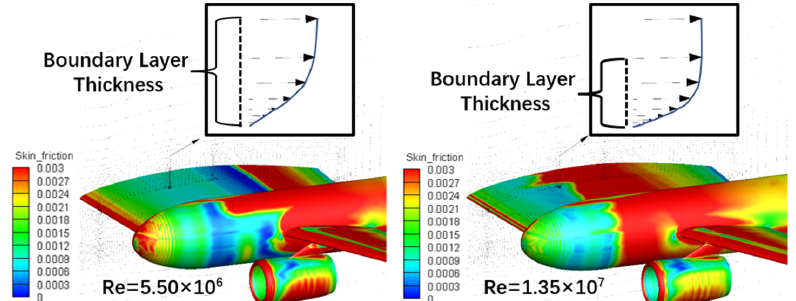
Figure 15. Comparison of the transition location of the central experiment wing with different Re .